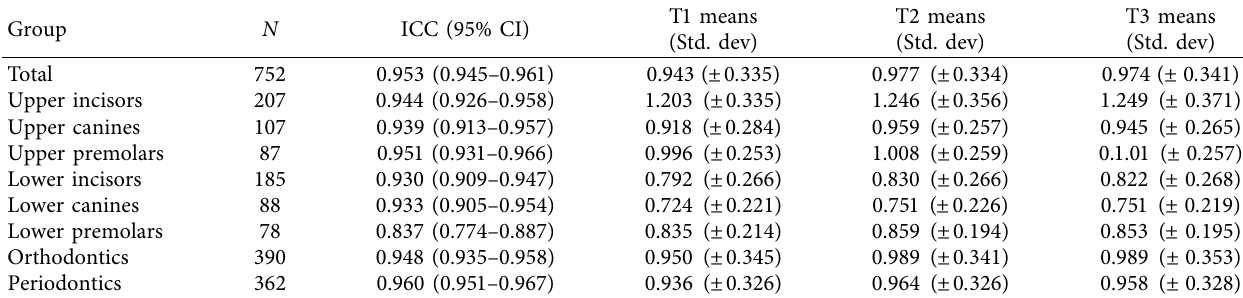
Table 3: Intrarater GT by tooth groups and clinic groups.